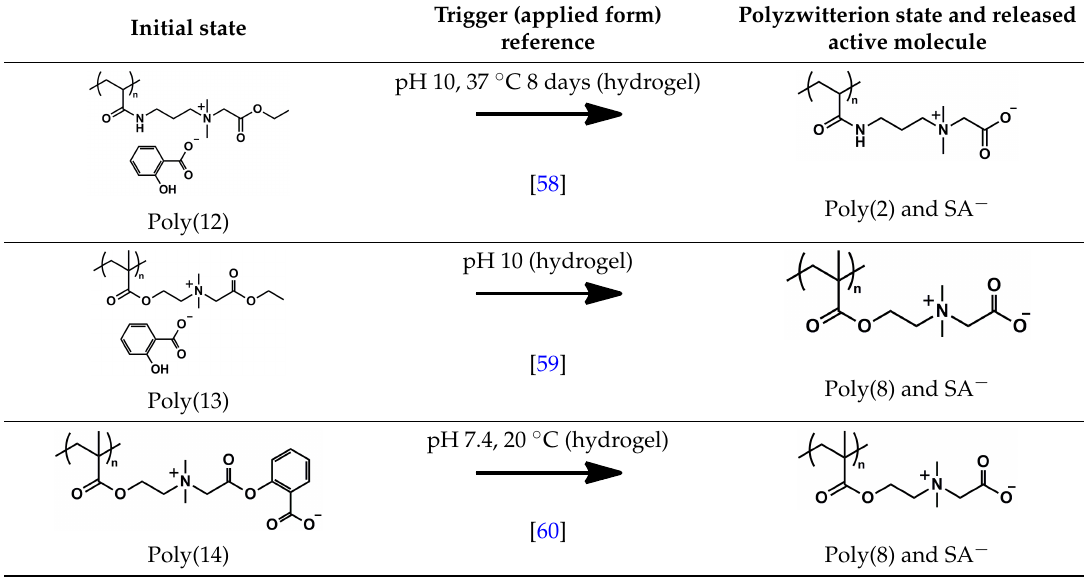
Table 1. Irreversible pH-triggered (meth)acrylic-based switches containing polyzwitterionic state.